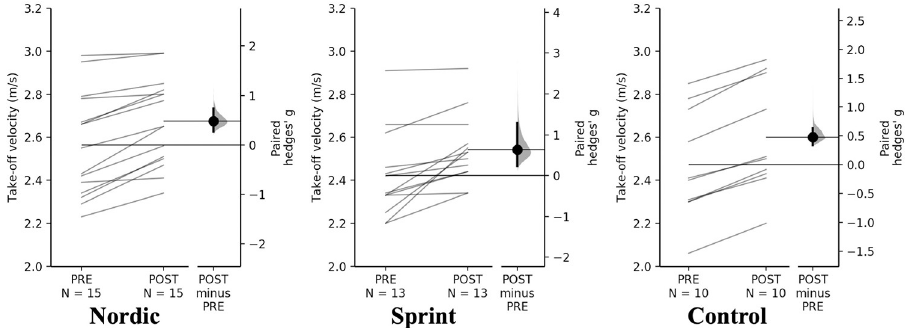
Fig 6. Gardner-Altman estimation plots identifying Pre- and Post-intervention individual changes for take-off velocity and Hedge’s g effect size with the 95% CI indicated by the ends of the vertical error bar.